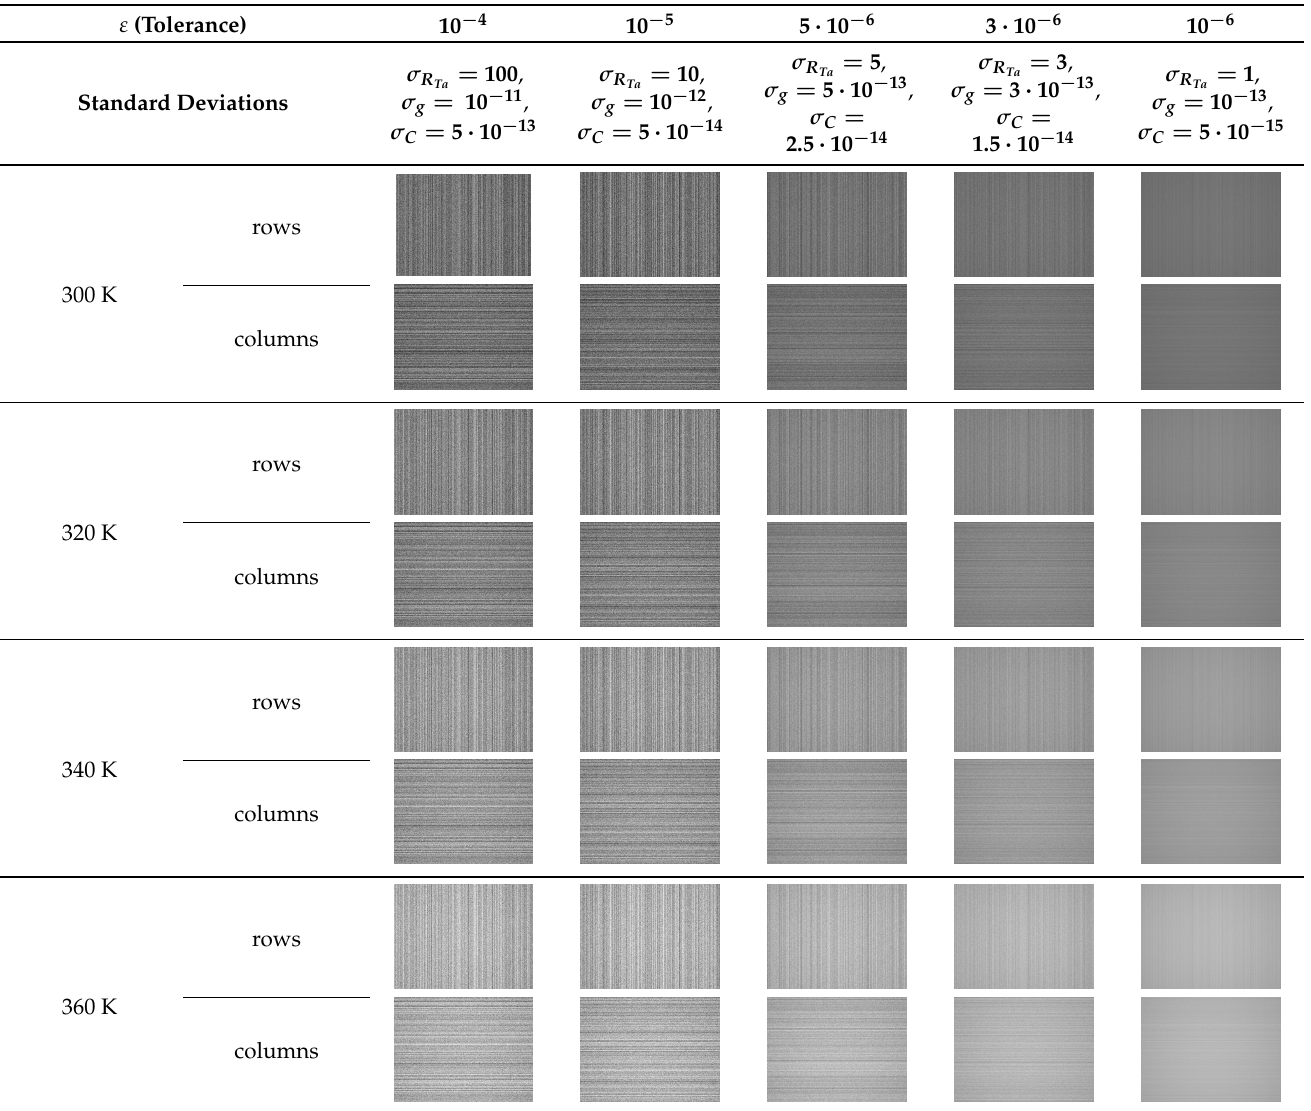
Table 1. Output data of the simulated model at variety of blackbody source temperatures (300–500 K) and bolometer and readout nominal values: microbolometer resistance at ambient temperature ( R Ta = 10 6 [ Ω ] ), thermal conductivity ( g = 10 − 7 [W/K]), thermal capacity ( C = 5 and tolerances ( ε ). σ R , σ g and σ C represent standard deviation of the parameters, where σ R Ta “rows” and “columns” refer to the used temperature correction method (column or row skimming pixels are used for the